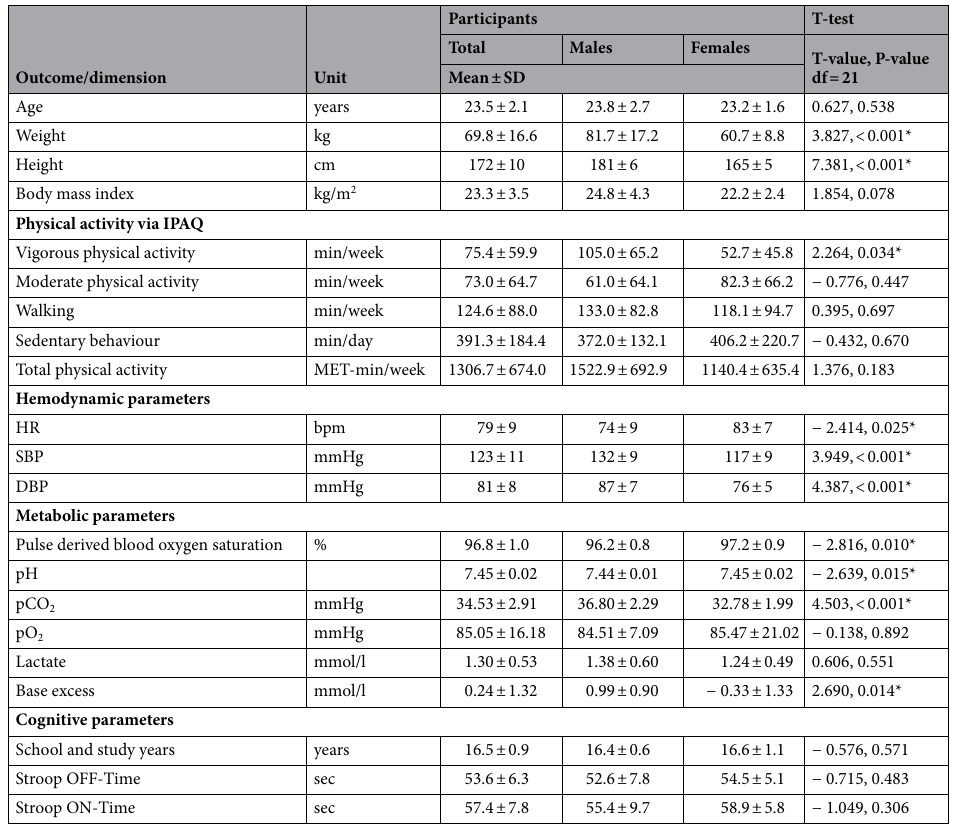
pressure of carbon dioxide, pO 2 partial pressure of oxygen, MET metabolic equivalent of task, min minute , bpm beats per minute, sec seconds. *Independent Samples